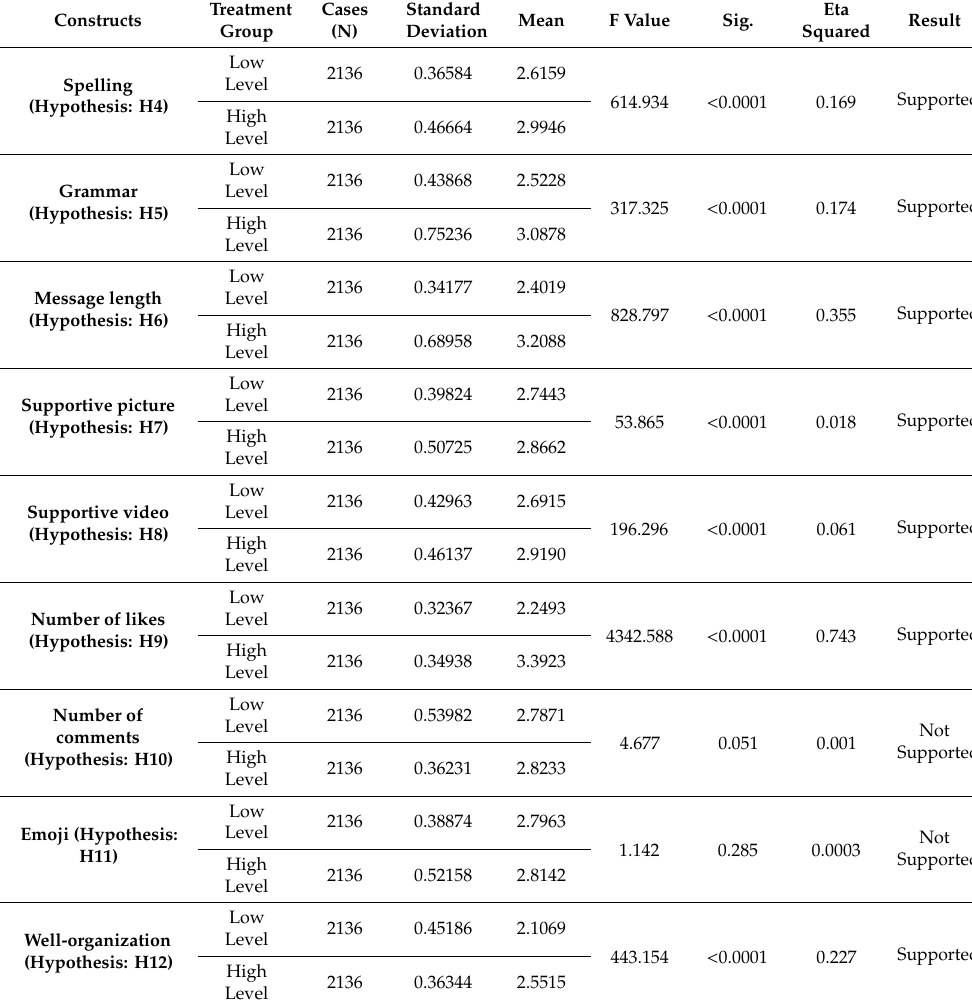
Table 6. One-way ANOVA and e ff ect sizes for hypotheses